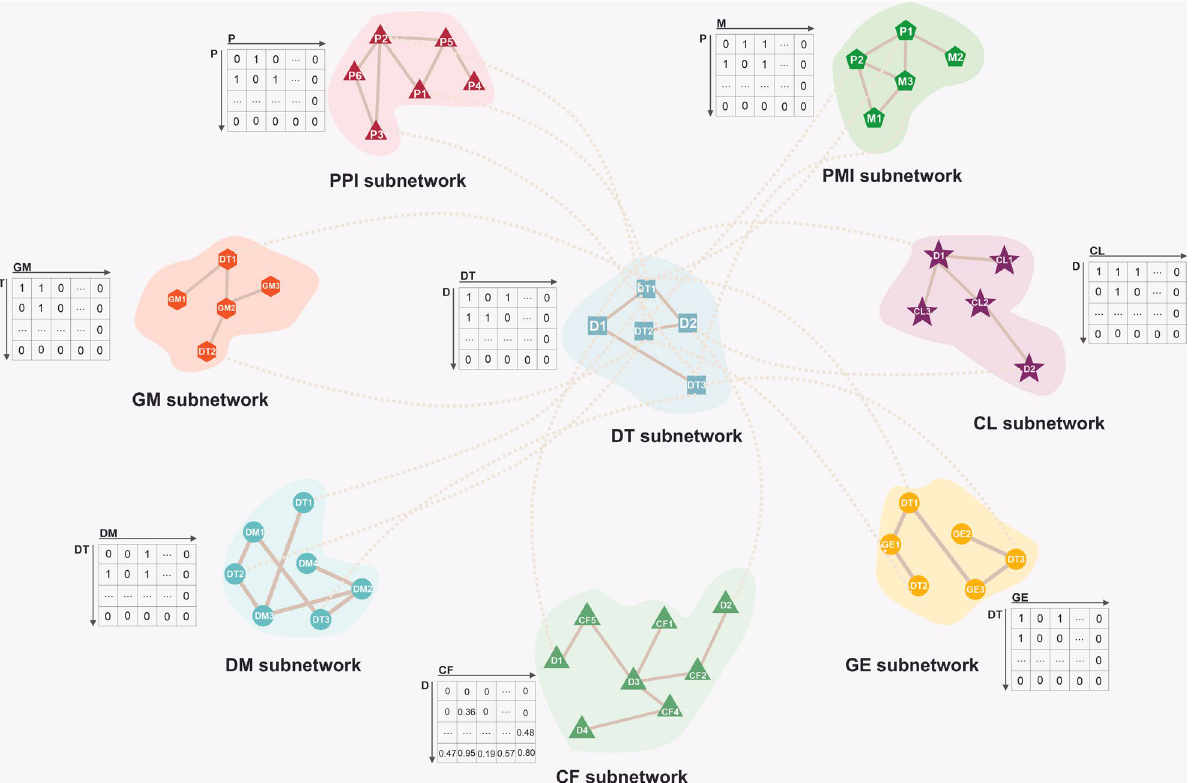
Figure 4. Construction of the heterogeneous network. The heterogeneous feature matrix was generated from drug-target, protein–protein interaction, protein-metabolite interaction, gene mutation, gene expression, differential methylation, chemical structures, and cell lines. The matrix values comprised zero, and non-zero